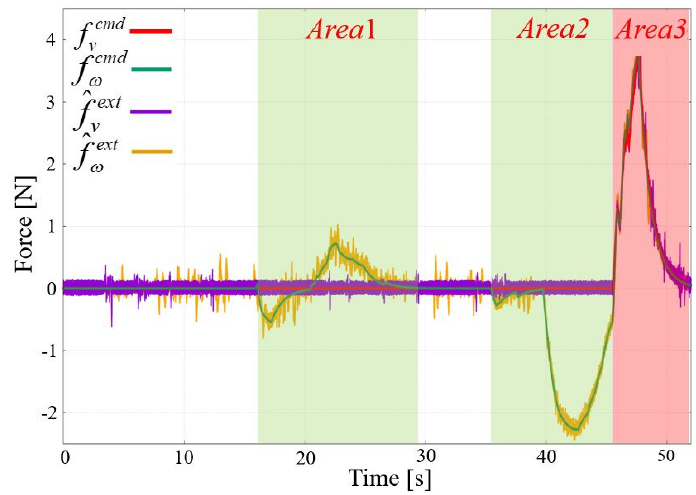
Figure 17. Experimental results of force commands of Case 3 for Subject A.